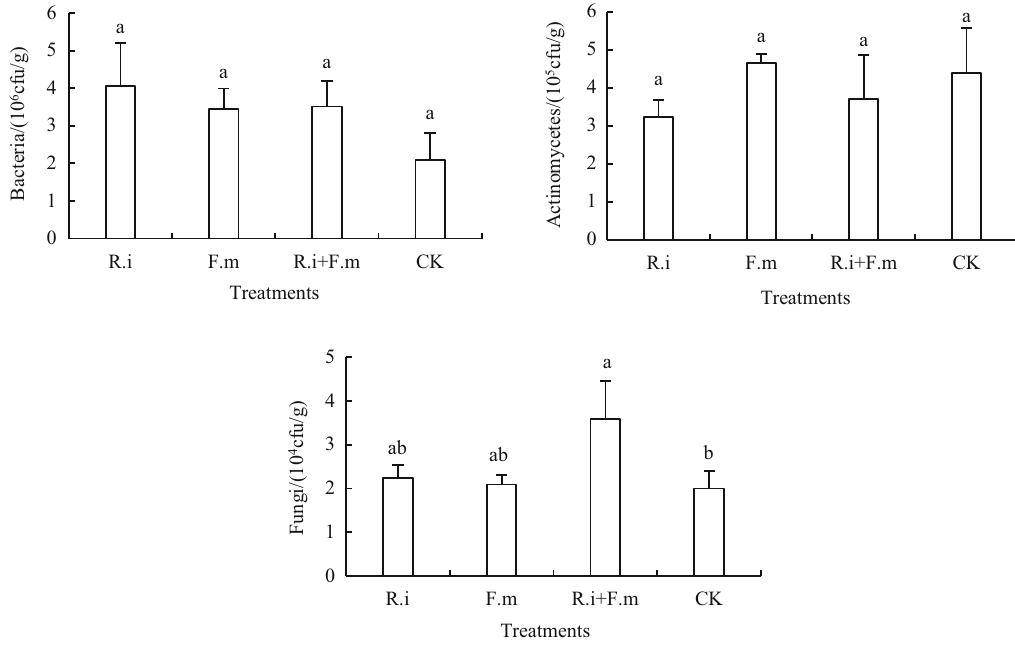
Fig. 6 Effect of AM inoculation on soil microbe populations of Amygdalus pedunculata